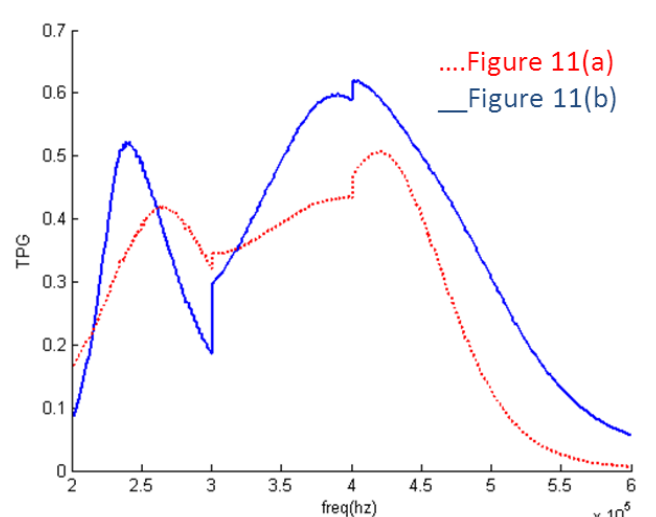
Figure 12. TPG of the EIMNs in Figure 11.